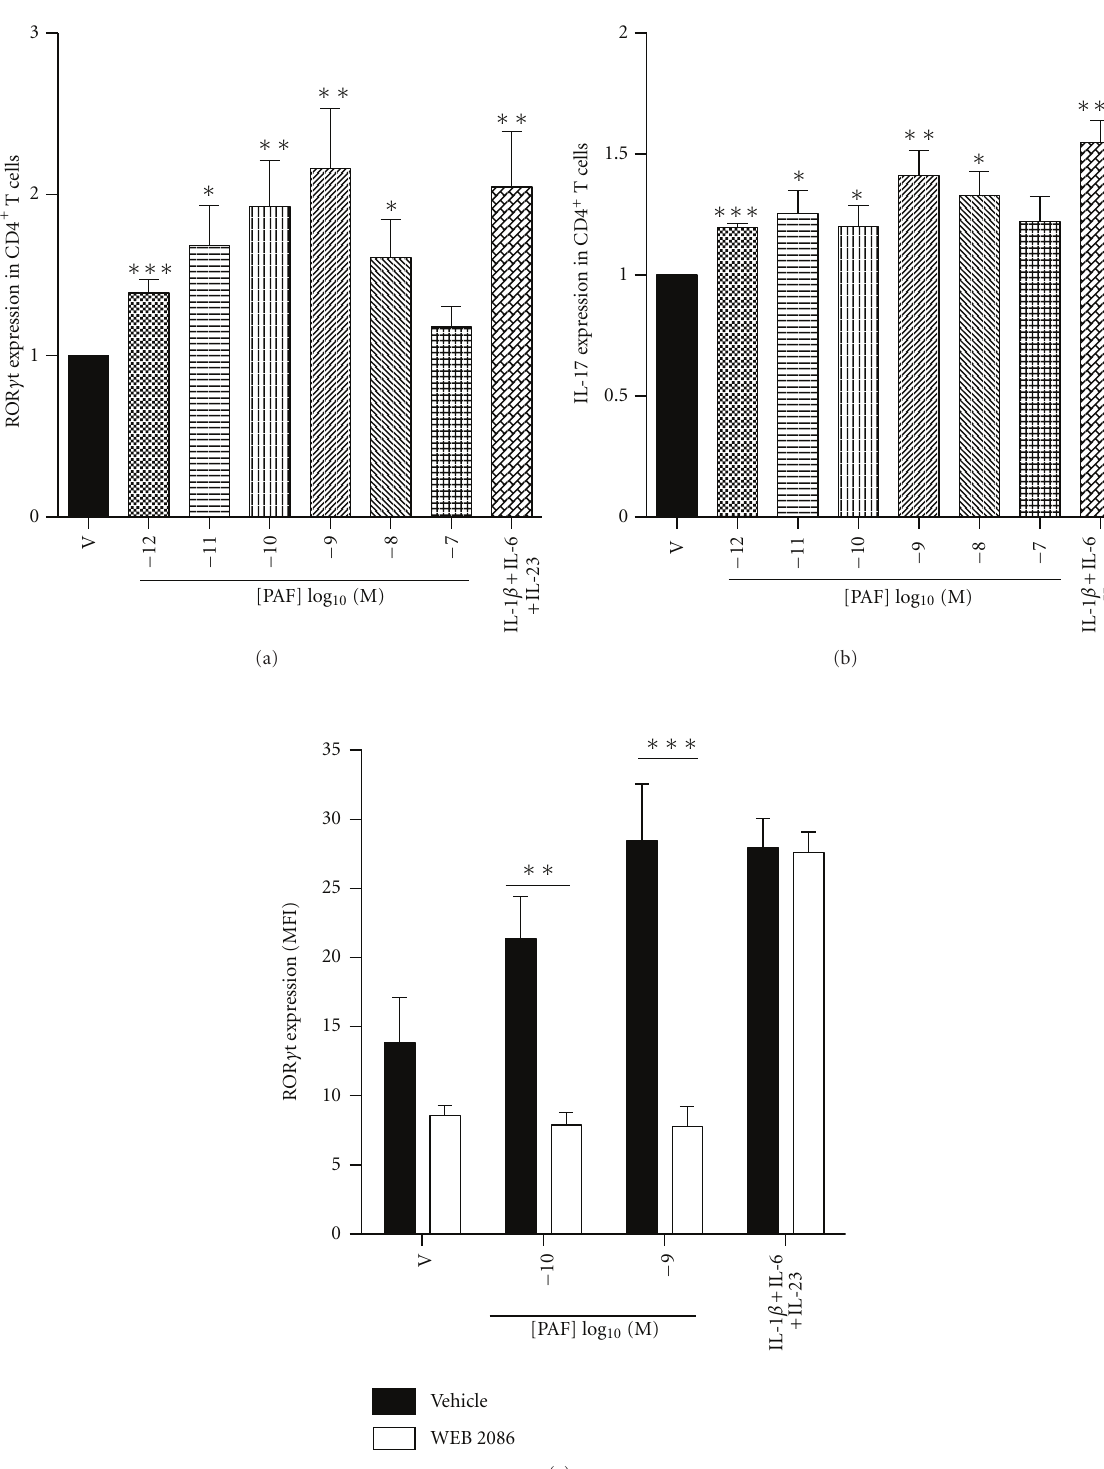
Figure 3: PAF-stimulated LC induce a Th17 phenotype in cocultured T cells. Monocyte-derived LC were stimulated with graded concentrations of PAF or its vehicle (ethanol; V) and cocultured with antiCD3/CD28-activated CD4 + T cells for 5 days. ROR γ t (a) and IL-17 (b) expression was measured by FACS in CD4 + T cells. For comparison, CD4 + T cells were cultured alone with IL-1 β , IL-6, and IL-23 for 5 days. Data (means ± SEM) are expressed as fold induction relative to vehicle (V) control. n = 10; ∗ P < 0 . 05; ∗∗ P < 0 . 01; ∗∗∗ P < 0 . 001. (c) LC were also stimulated with either vehicle or PAF in the absence or presence of the PAFR antagonist WEB 2086 (10 − 5 M) and cocultured with anti-CD3/CD28-activated CD4 + T cells for 5 days. ROR γ t expression was measured by FACS in CD4 + T cells and expressed as geometric mean ( ± SEM) fluorescence intensity (MFI). n = 5; ∗∗ P < 0 . 01; ∗∗∗ P < 0 .